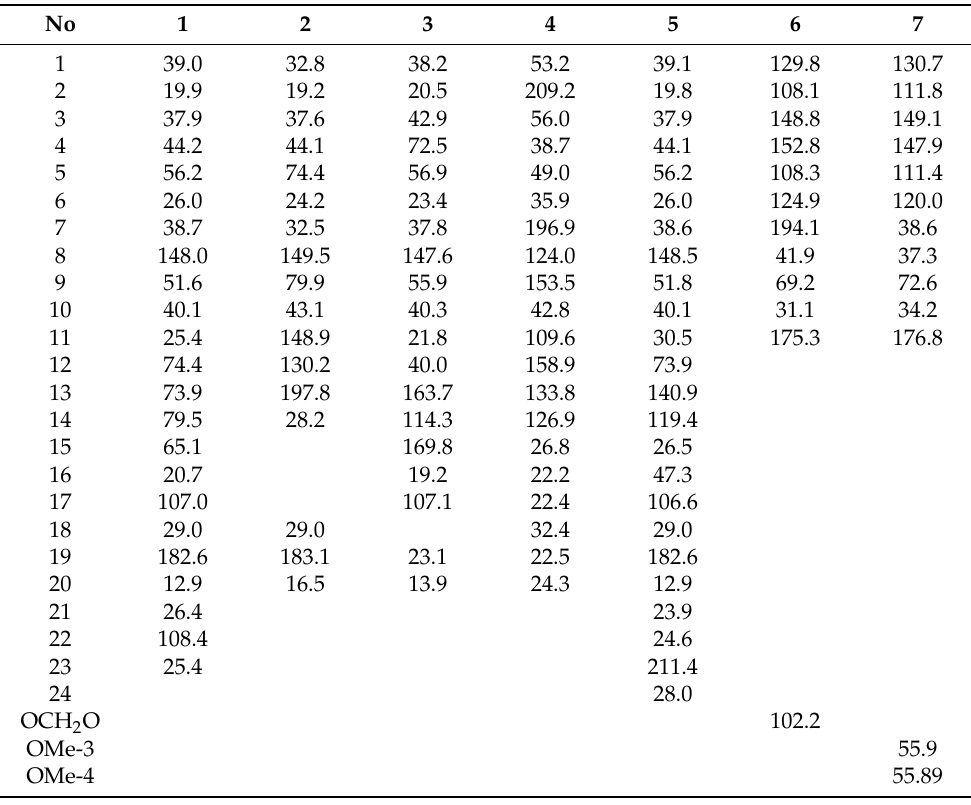
Table 2. 13 C NMR data for Compounds 1 – 7 ( δ in ppm, 125 MHz for 13 C NMR in CDCl 3